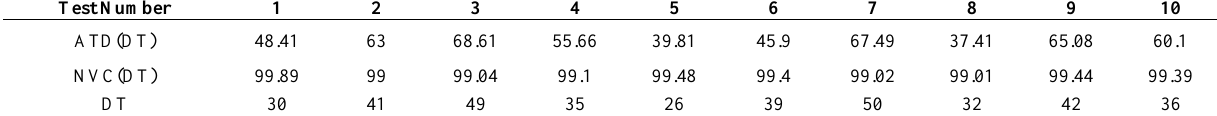
Table 3. Results of ten experiments with scenario 2 (bounded node degree). Test Number